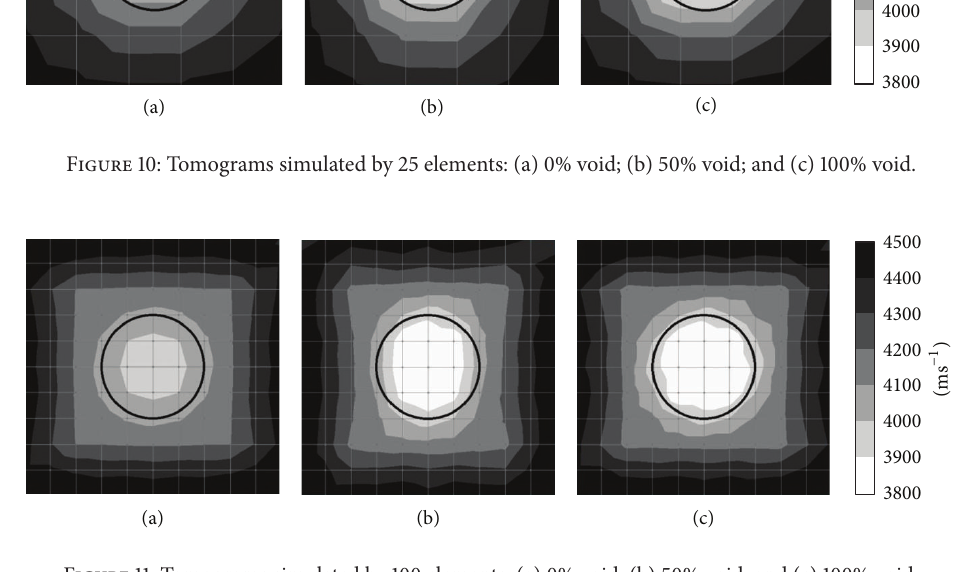
Figure 11: Tomograms simulated by 100 elements: (a) 0% void; (b) 50% void; and (c) 100%